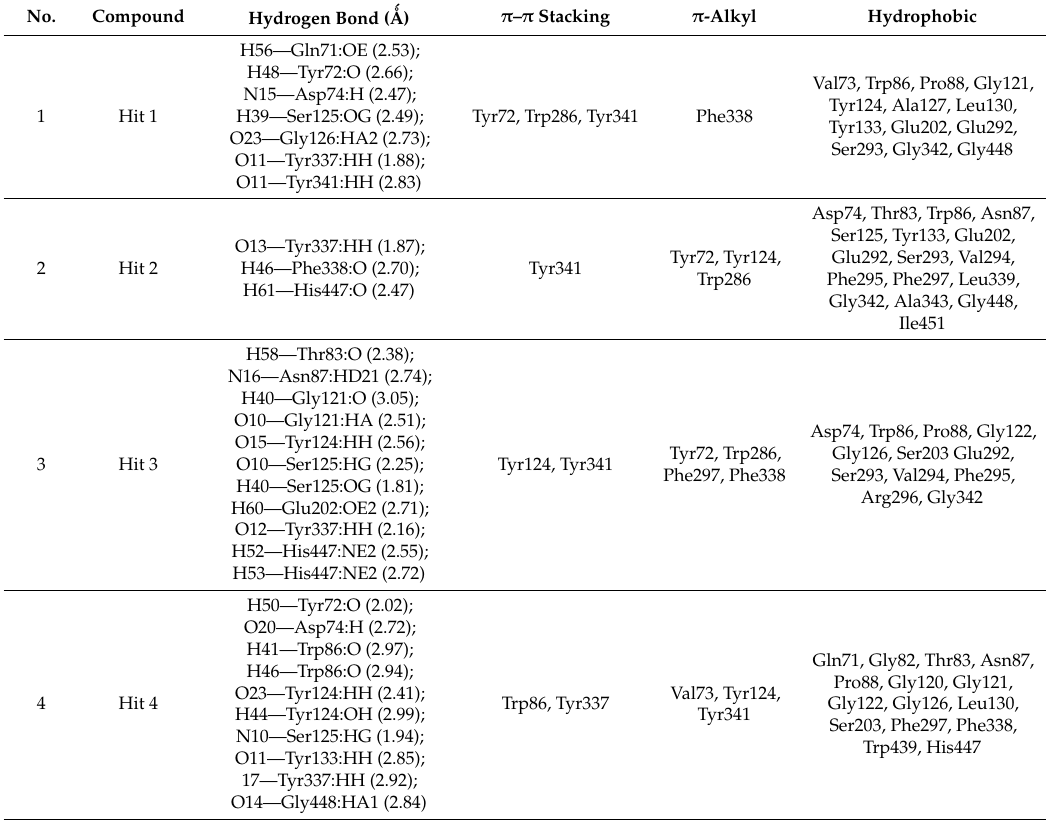
Table 3. Molecular interactions between hAChE and the final hit